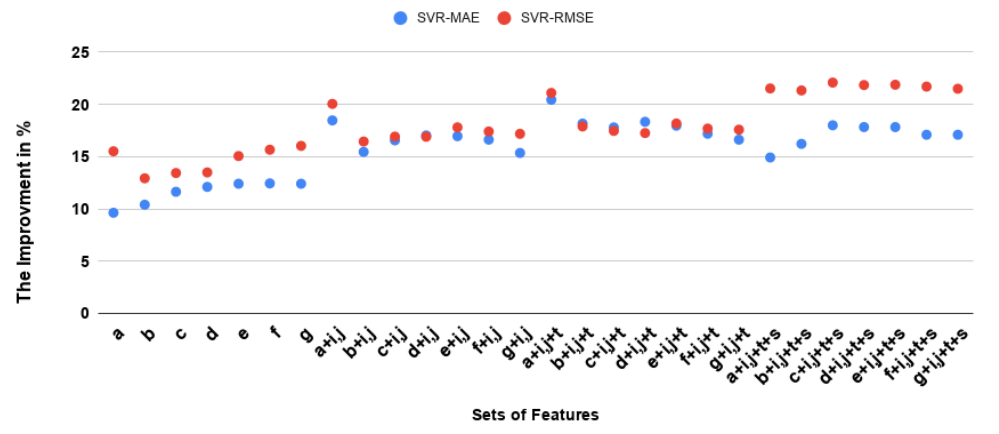
Figure 8. Performance improvement of SVR versus the untrained previous month regressor.